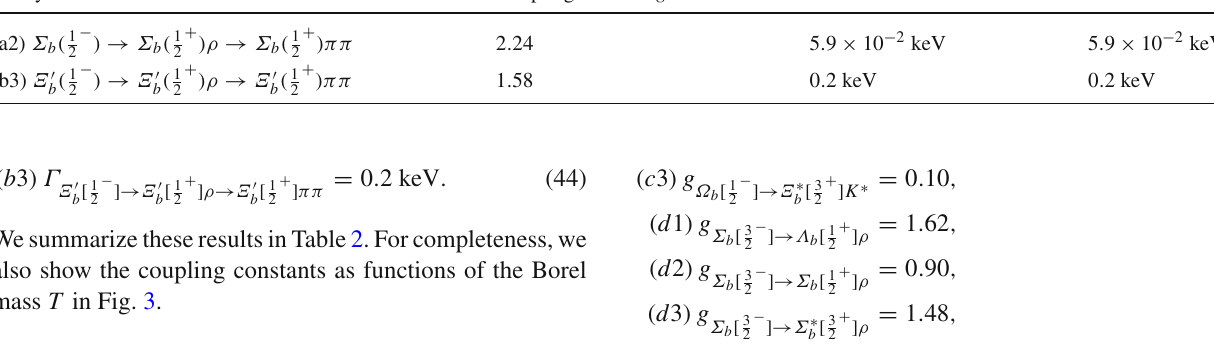
Table 2 S -wave decays of P -wave bottom baryons belonging to the doublet [ 6 F , 0 , 1 ,λ ] into ground-state bottom baryons and vector mesons Decay channels Coupling constant g Partial